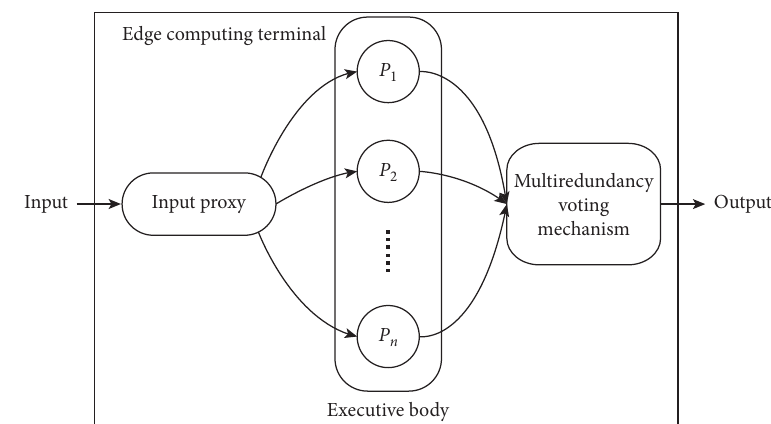
Figure 3: Single-redundancy mimic defence iPo